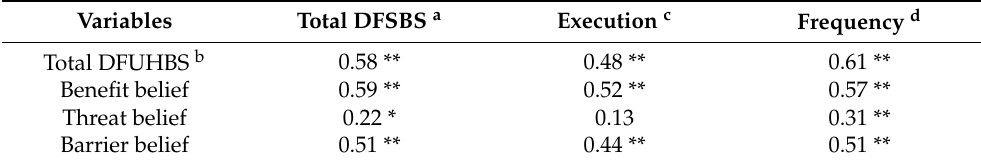
Table 3. Pearson correlation (r) between diabetic foot ulcer health beliefs and self-care behavior. Variables Total DFSBS a Execution c Frequency d Total DFUHBS b 0.58 ** 0.48 ** 0.61 ** Benefit belief 0.59 ** 0.52 ** 0.57 ** Threat belief 0.22 * 0.13 0.31 ** Barrier belief 0.51 ** 0.44 ** 0.51 **